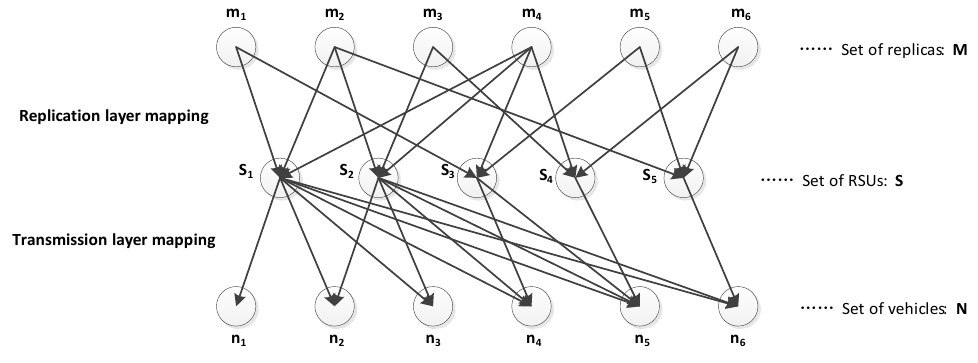
Figure 5. Two layer mapping